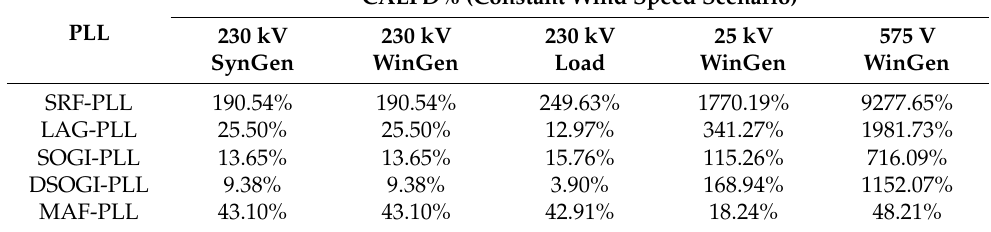
Table 4. Cumulative relative AEFD values for the PLLs located at the different buses in the constant wind speed